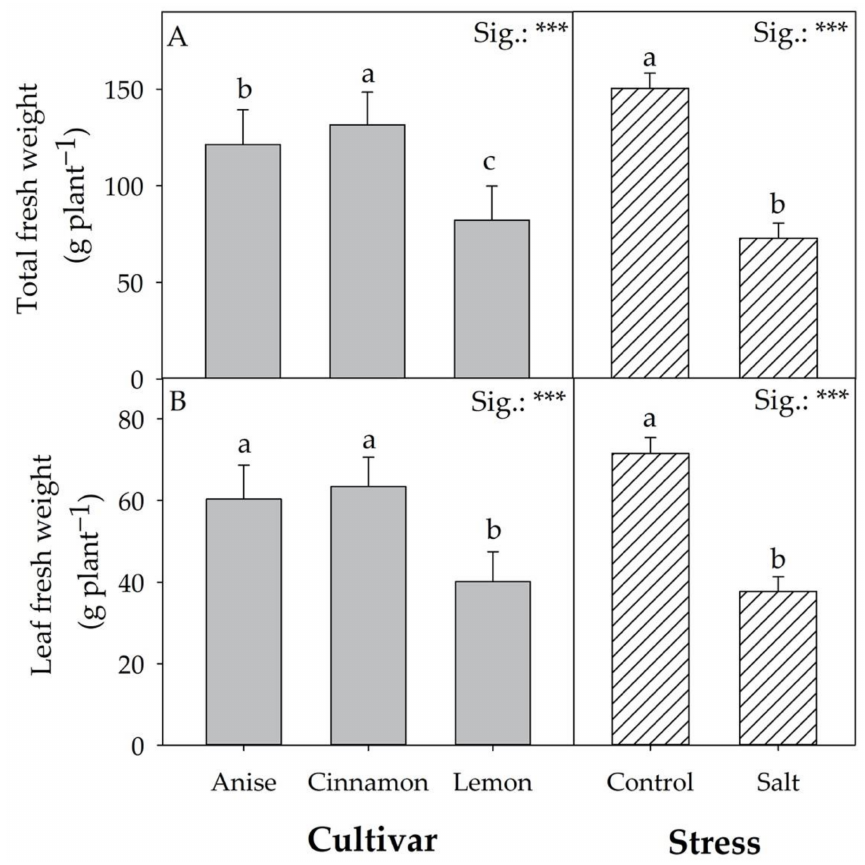
Figure 2. Effect of Cultivar and Stress on total fresh weight ( A ) and leaf fresh weight ( B ). Data are mean values ± standard error, n = 3. Mean comparisons were performed by Tukey HSD test for Cultivar and by t -Test for Stress. Different letters indicate significant mean differences. *** denotes significant effects at p ≤